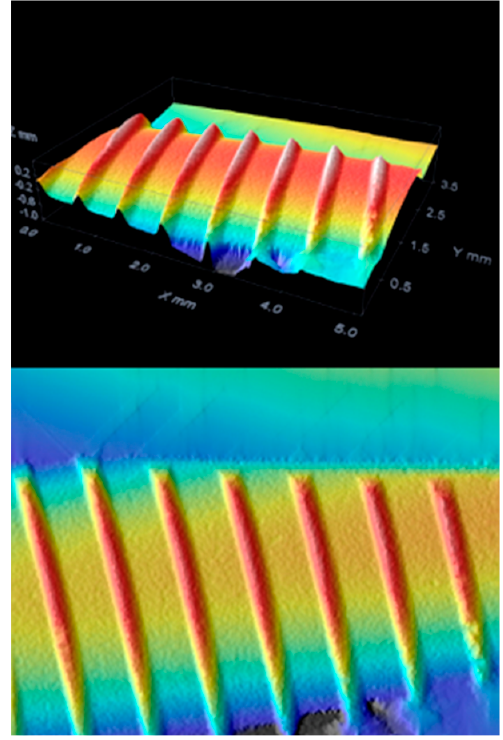
Figure 4. Competitor 1 confocal microscopy.